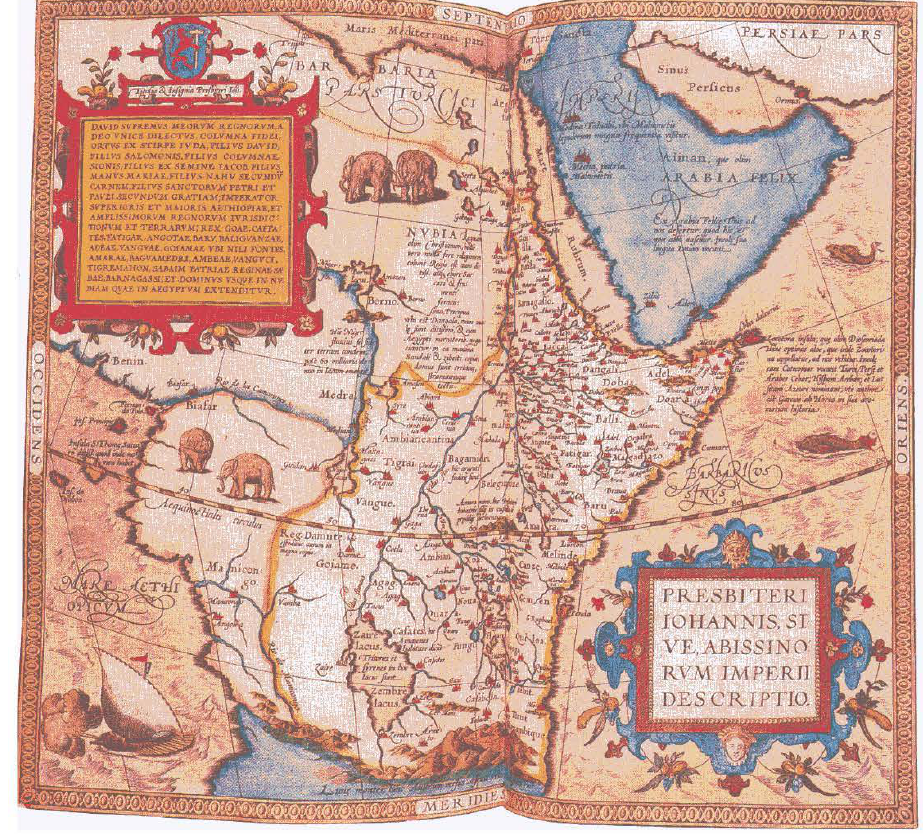
Figure 4: "Presbiteri Iohannis". Ortelius, Abraham (1573). "Presbiteri Iohannis ... " [map], in Theatrum Orbis Terrarum,